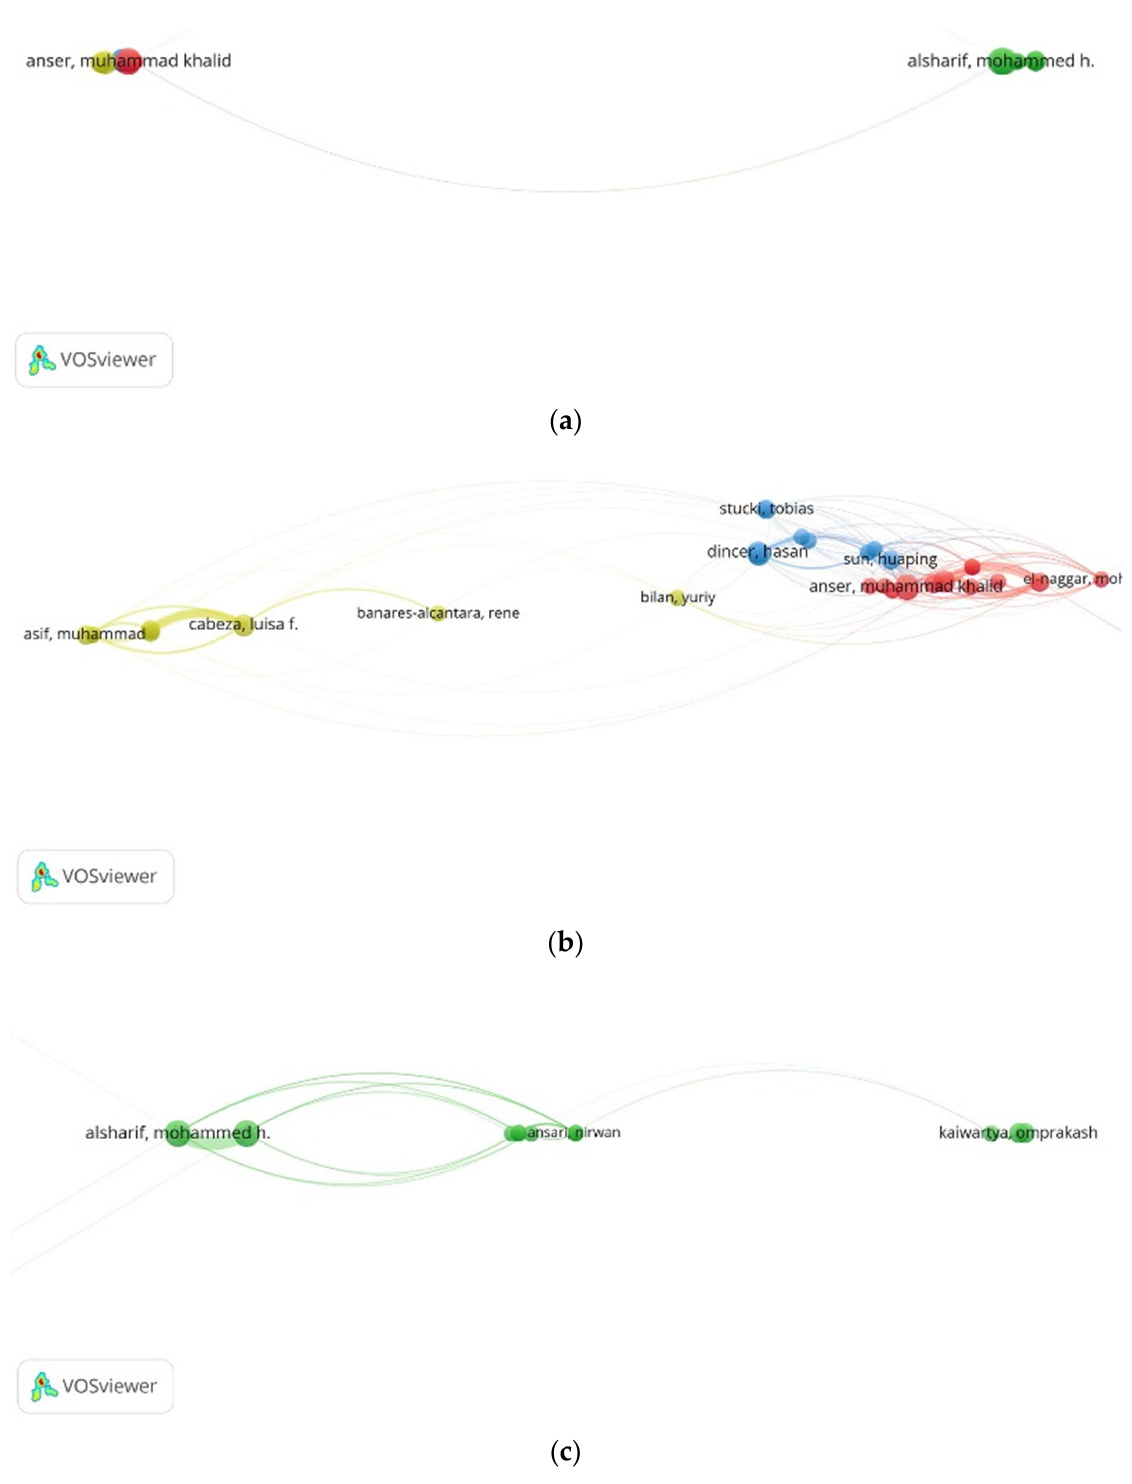
Figure 6. ( a ) Authors bibliographic coupling map. ( b ) Authors bibliographic coupling map—clusters 1–3. ( c ) Authors bibliographic coupling map—cluster 4.